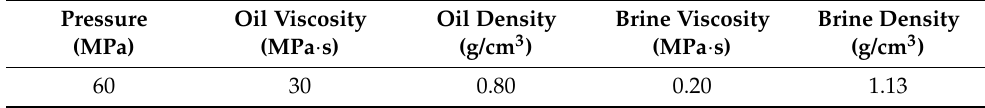
Table 1. Simulation parameters (reservoir